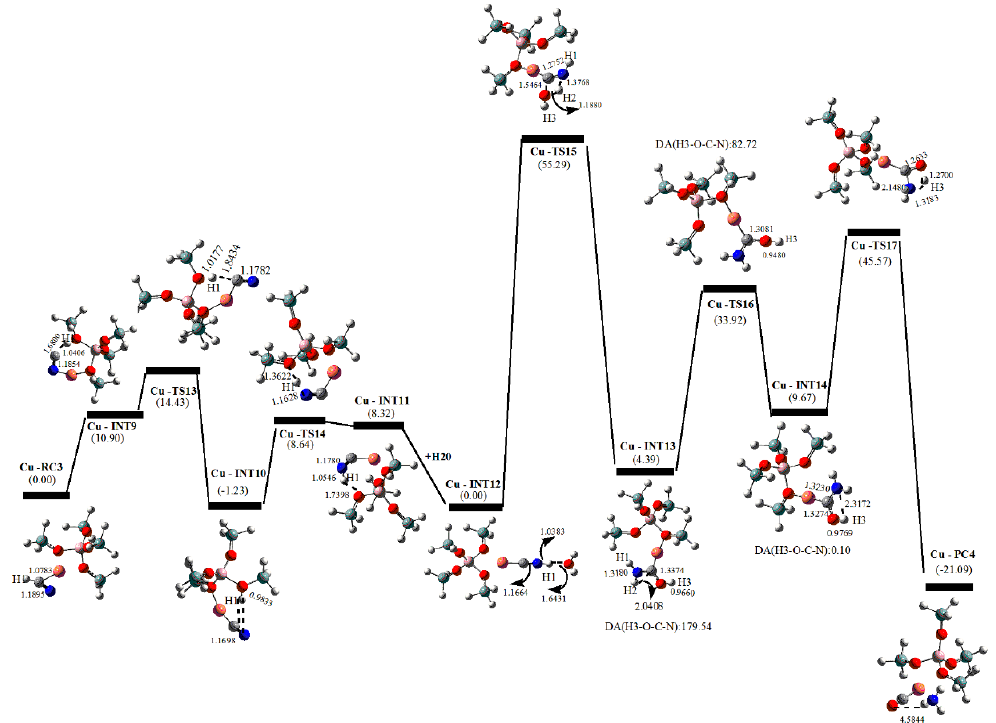
Figure 7. B3LYP/6-31++G (d,p)-optimized structures (in Å) of the stationary points of hydrolysis of HCN with Cu-ZSM5 in the gas phase for the path D. The values correspond to the relative free energy ( ∆ G) in kcal/mol with respect to the separate reactants.